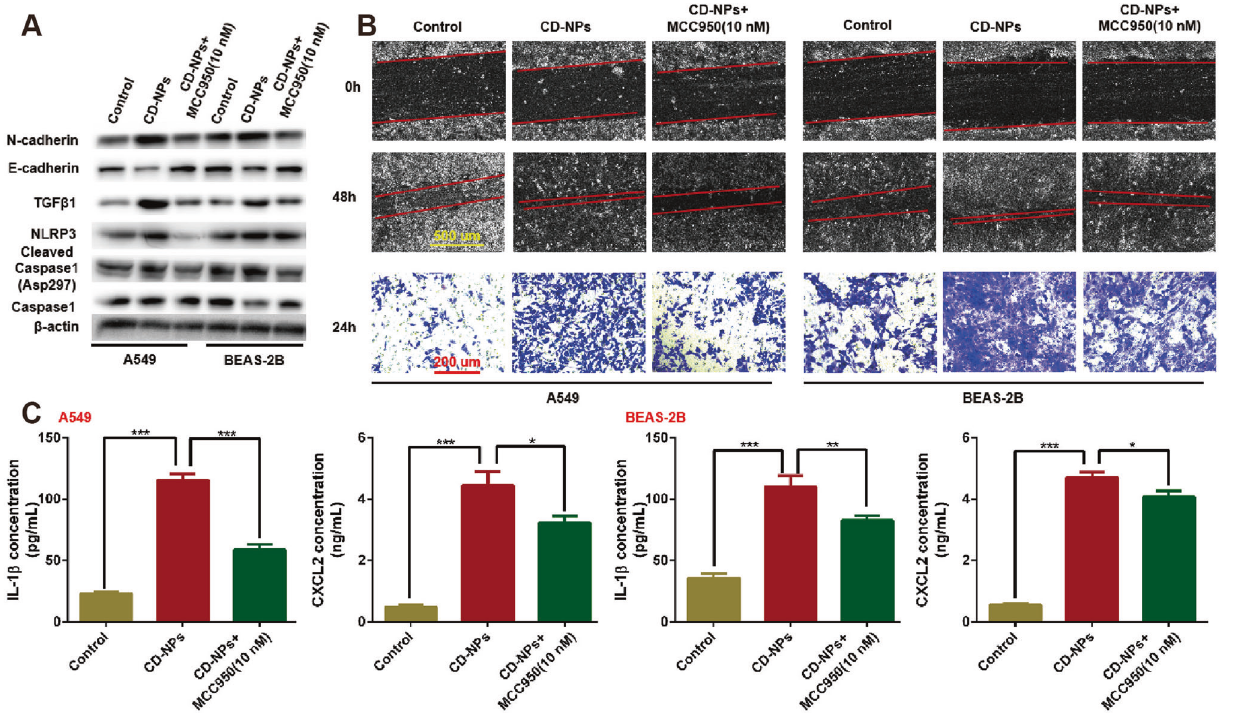
Fig. 7 Inhibition of NLRP3 reverses the effects of CD-NPs on in fl ammation and EMT in vitro. A The expression levels of EMT marker molecules (N-cadherin, E-cadherin and TGF β 1) and in fl ammatory pathway protein molecules (NLRP3, Cleaved Caspase1/Caspase1) were detected by western blot. B The migration and invasion abilities of alveolar epithelial cells were detected by scratch healing assay and transwell assay. C In fl ammatory factor IL-1 β and in fl ammatory chemokine CXCL2 the supernatant of alveolar epithelial cells were detected by ELISA. Data were expressed as the mean ± SD, n = 3. * P < 0.05, ** P < 0.01 and *** P <